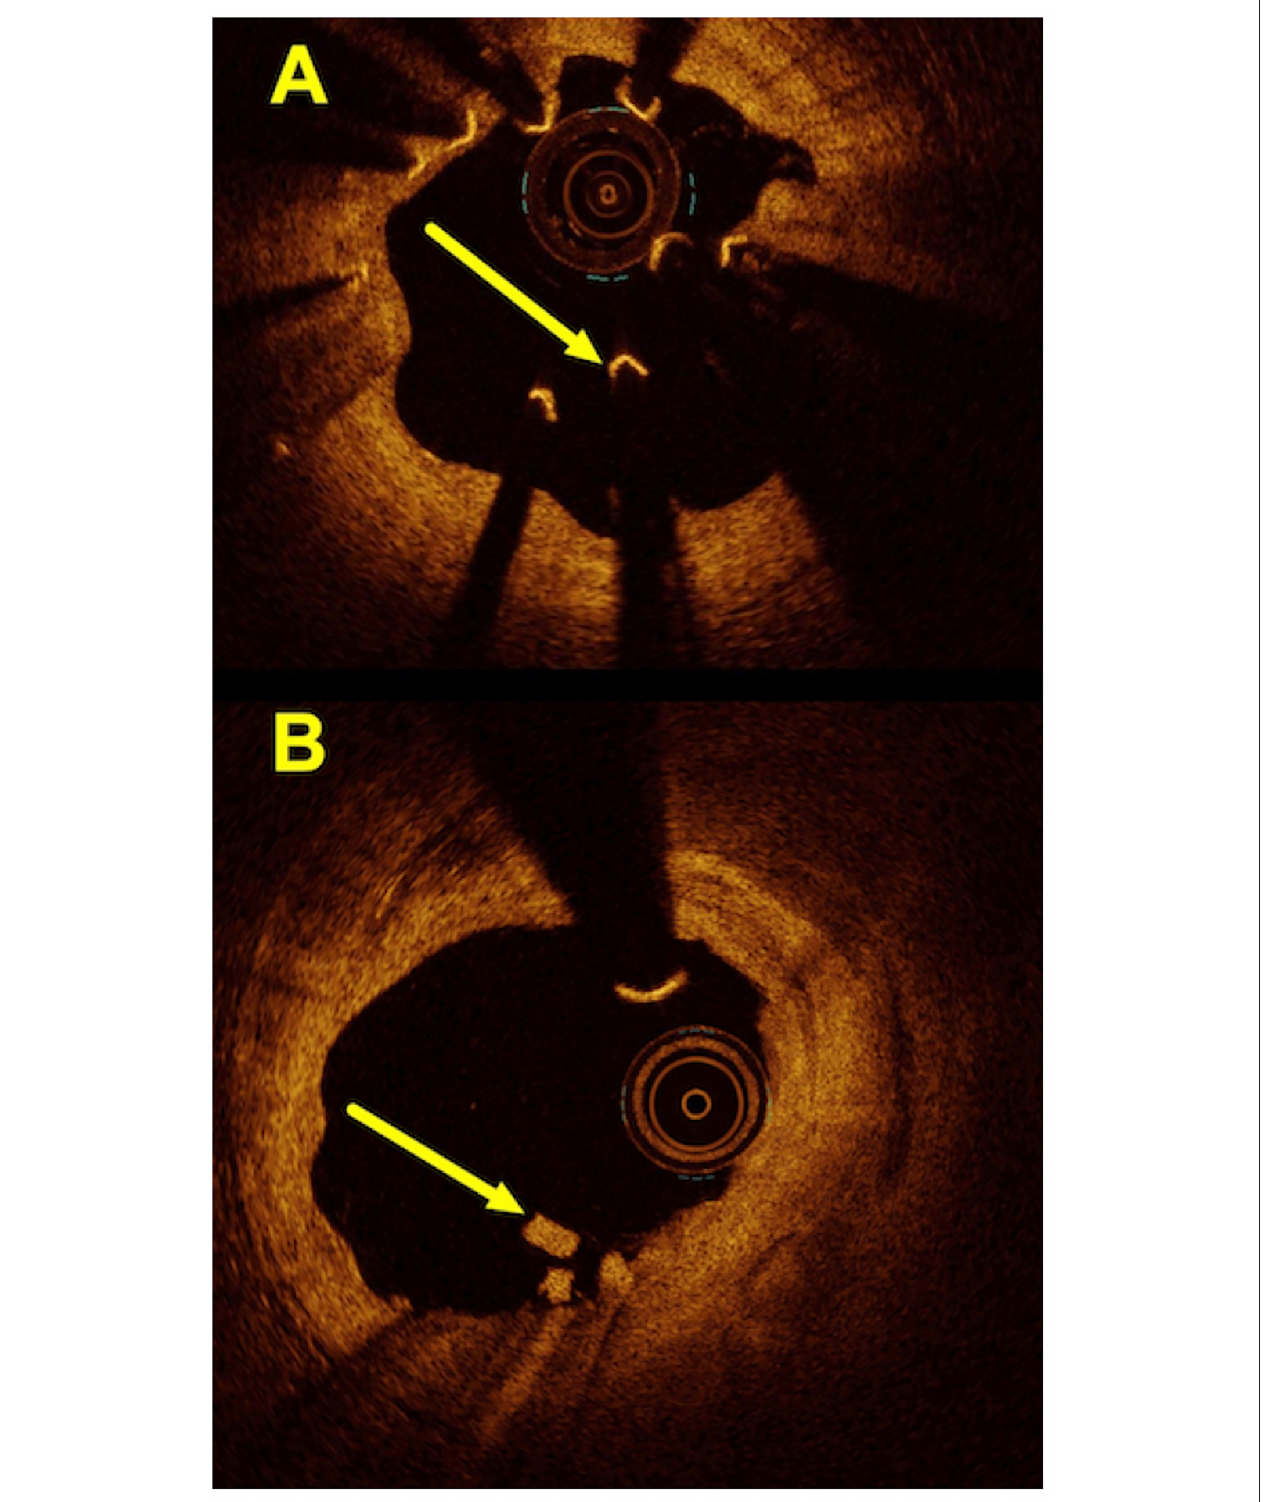
FIGURE 2 | Hallmark OCT findings encountered in patients with the Mg-BRS-related target lesion failures: (A) scaffold collapse; (B) uncontrolled device dismantling. (A) This OCT image shows a collapsed scaffold with seemingly “free-floating” struts ( arrow ), which are no longer embedded and apposed to the coronary artery’s wall. Also, the inner lumen appears to have restenosis with significant luminal irregularities and tissue protrusion. (B) This illustrates an incompletely dismantled Mg-BRS with residuals of struts protruding into the vascular lumen ( arrow ). Also, the intima appears partially irregular (1–5 o’clock). Mg-BRS, magnesium-based sirolimus-eluting bioresorbable scaffold; OCT, optical coherence tomography.